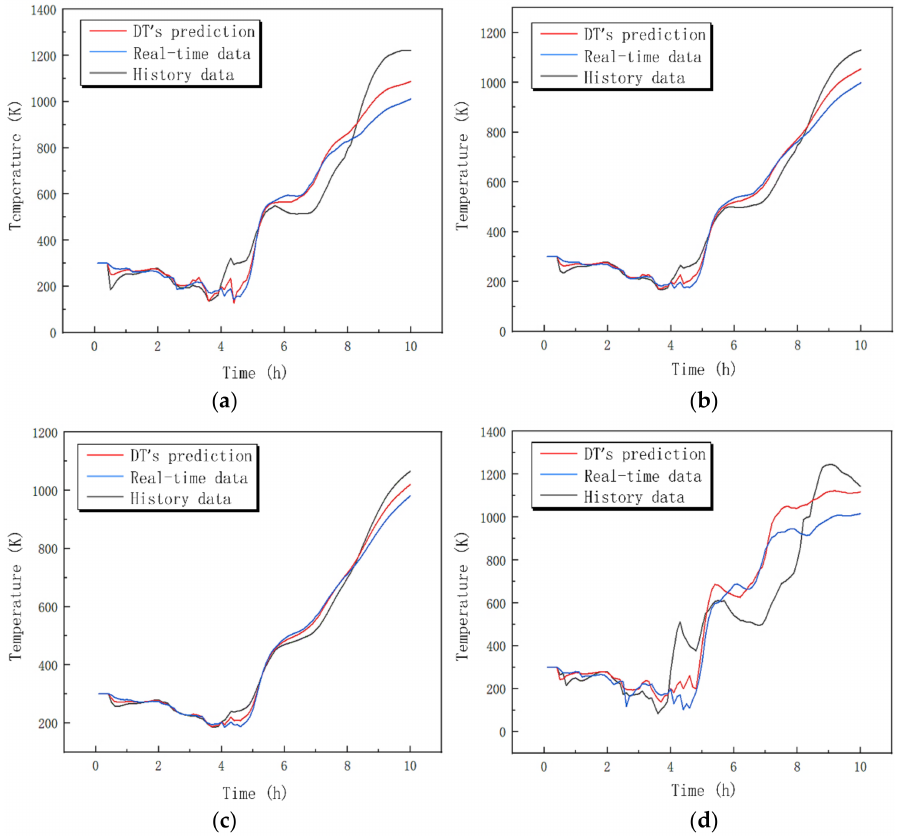
Figure 5. Comparison between DT’s prediction, real-time data and historical data. ( a ) Condition 1. ( b ) Condition 2. ( c ) Condition 3. ( d ) Condition